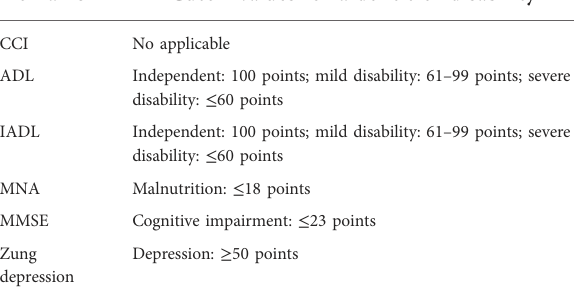
TABLE 1 Cutoff values for the six domains of our comprehensive geriatric assessment.